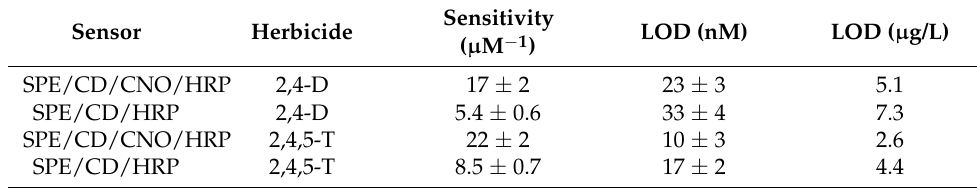
Table 1. Analytical parameters of the developed biosensors.